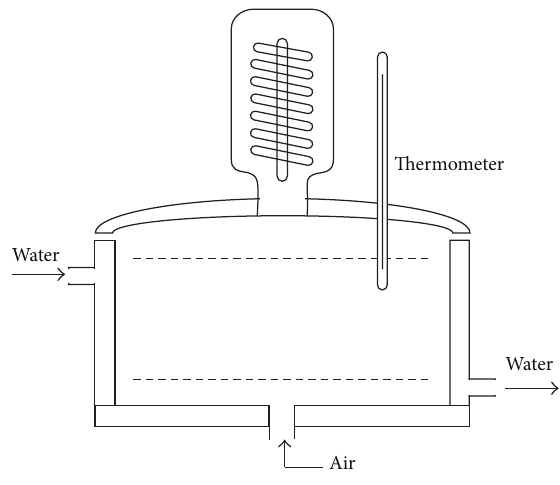
Figure 5: Schematic diagram of biodegradation test